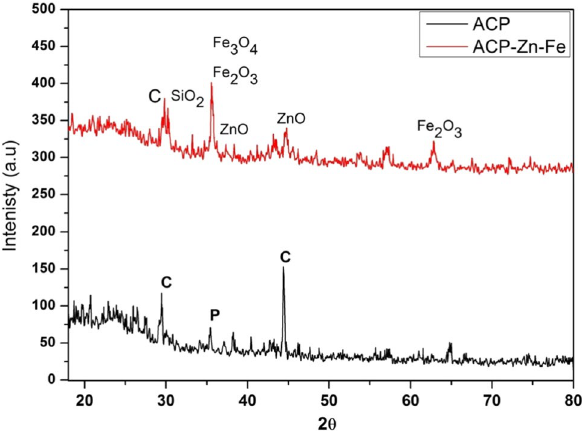
Fig. 3 XRD profiles of the prepared samples